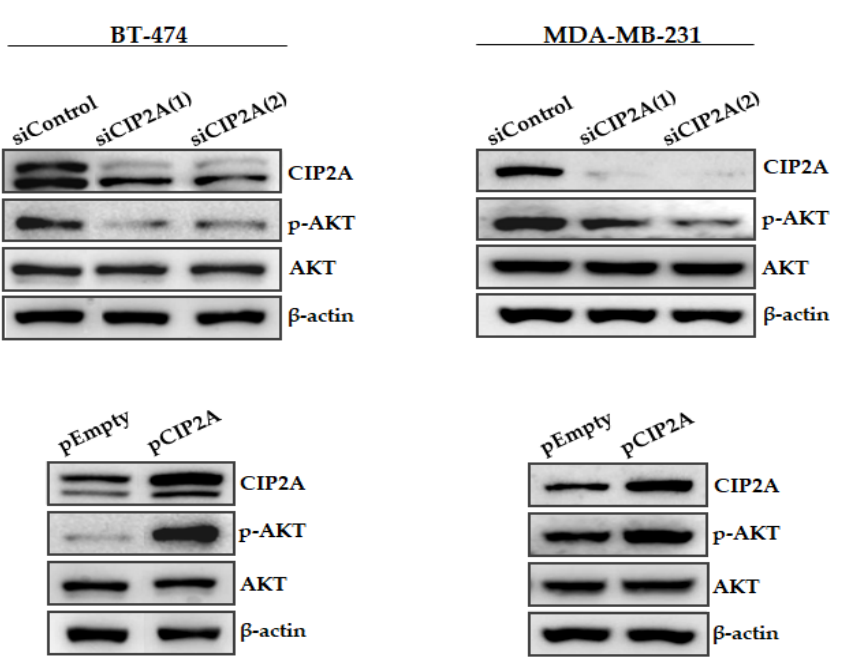
Figure 2. Western blot analysis showing CIP2A and p-AKT expression levels in breast cancer cell lines after ectopic CIP2A modulation.